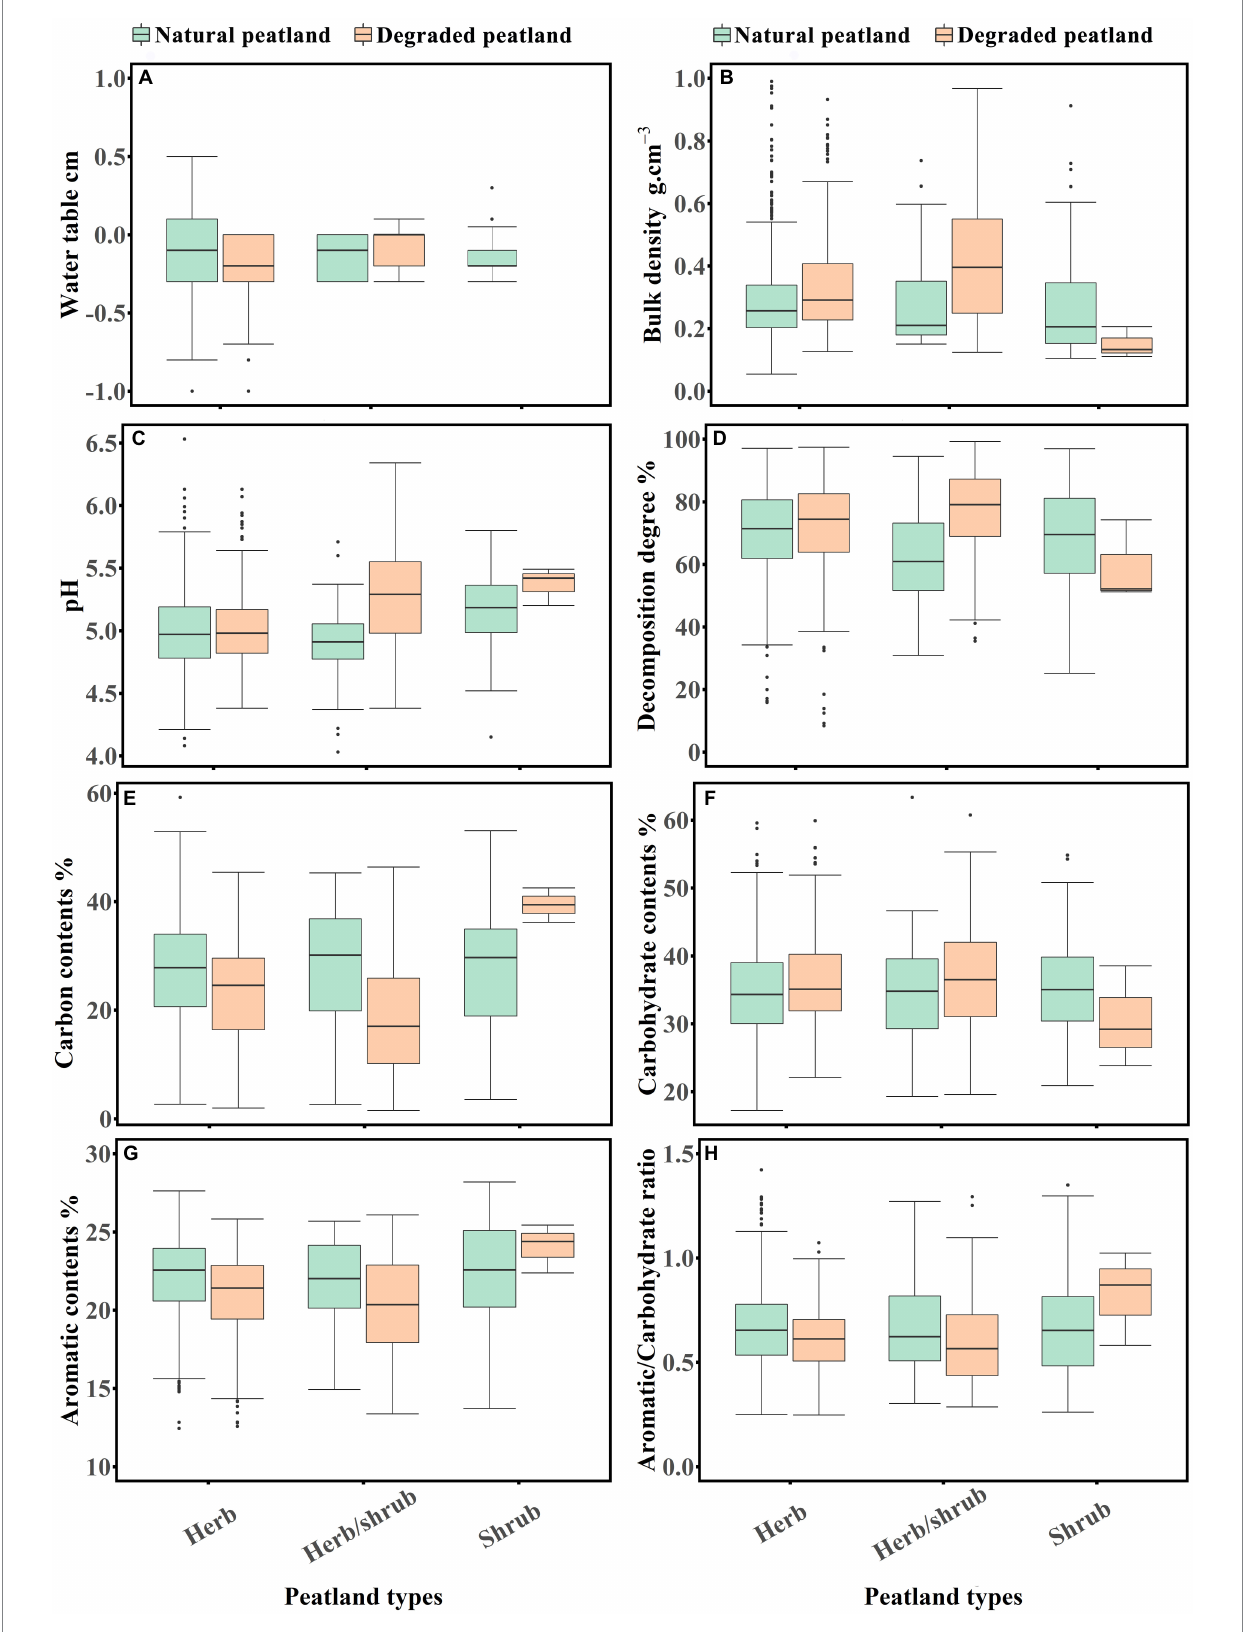
FIGURE 2 Boxplot of water table (A) , bulk density (B) , pH (C) , decomposition degree (D) , carbon contents (E) , carbohydrate contents (F) , aromatic contents (G) , and the ratio of aromatic/carbohydrate (H) of peat soils in different dominated plant types of natural and degraded